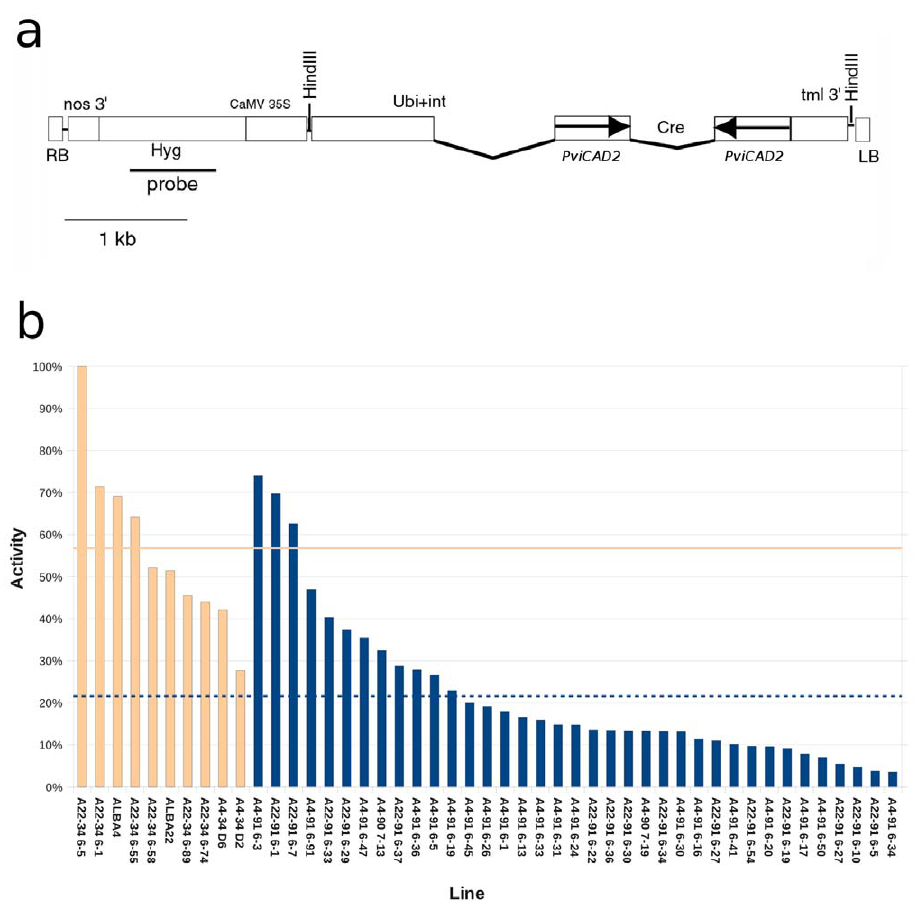
Figure 1. Design of silencing construct used for transformation and screening of regenerants for CAD activity. ( a ) The region between the T-DNA left (LB) and right (RB) regions are shown as open rectangles. Arrows indicate orientation relative to the direction of normal transcription.Abbreviations: Nopaline synthase terminator (nos3 9 ); Maize ubiquitin promoter and 5 9 untranslated intron (Ubi + int); Hygromycin hpt antibiotic resistance marker (Hyg); Cauliflower Mosaic Virus 35S promoter (CaMV 35S); A. tumefaciens Tml 3 9 transcriptional terminator (tml 3 9 ); Barley Cre intron (Cre); Nucleotides nucleotides 153–727 of PviCAD2 ( PviCAD2 ). A line below the drawing representing 1 kb is included for scale. The region used as a probe for DNA blot-hybridization is shown as a solid line below the drawing. ( b ) Reduction of coniferaldehyde (forward direction) in stem extracts. Activity is expressed as a percentage of highest level. Control untransformed regenerants and vector transformed regenerants are light orange. Individual regenerants transformed with pEC129 are shown as dark blue. Dashed light orange and dark blue lines indicate averages of the control lines and pEC129 regenerants respectively. Lines derived from ALBA22 are indicated with the prefix A22 and lines derived from ALBA4 are indicated with the prefix